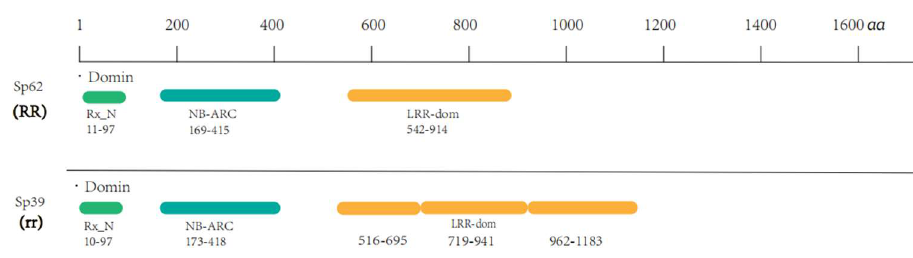
Figure 2. Result of Spo12821 protein structure prediction.